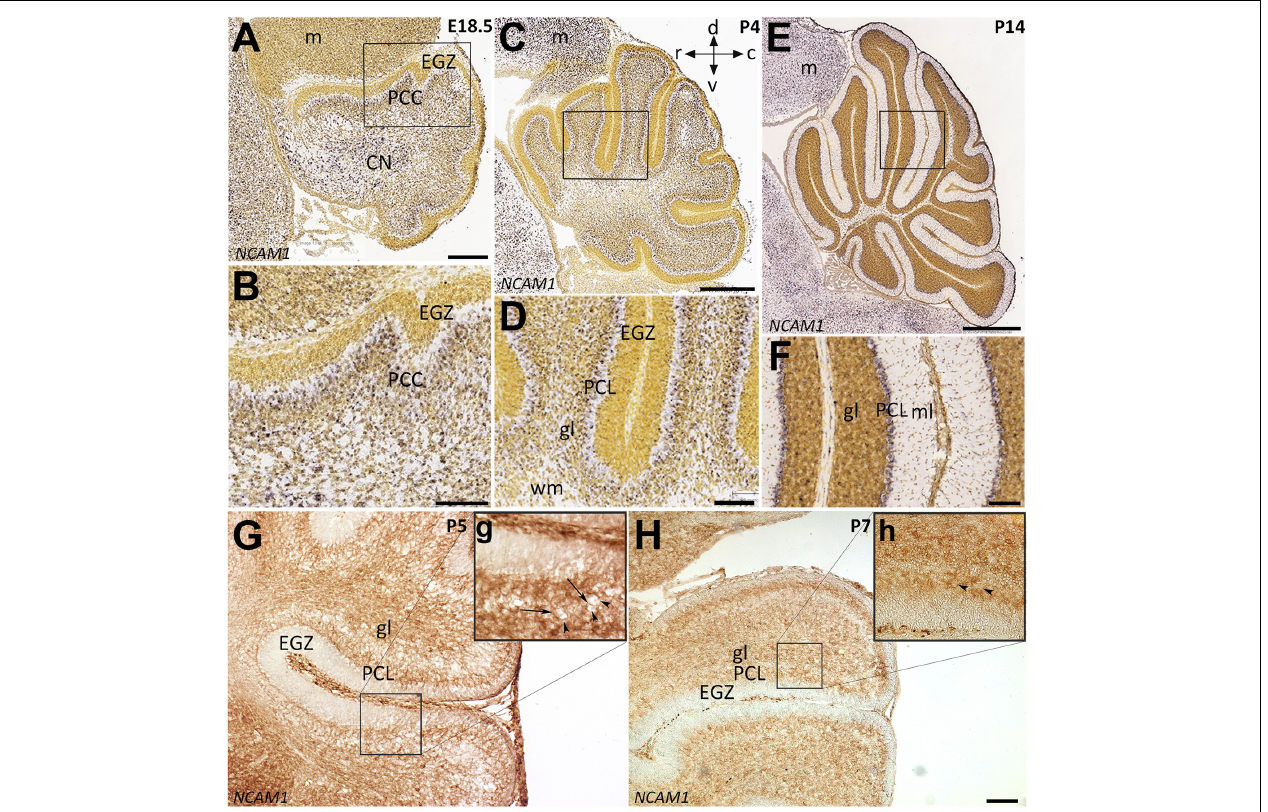
FIGURE 3 | Distribution of NCAM1 in sagittal sections hybridized in situ with antisense riboprobes specific for NCAM1 and immunoperoxidase staining in the cerebellum during development. Positive territories are labeled black. (A–D) NCAM1 expression at E18.5 and P4 is localized generally in whole cerebellum mostly in PC cluster and CN, except in EGZ and VZ (E18.5; A and P4; C , and higher magnification in B,D ). (E,F) At P14, NCAM1 expression is localized in PC layer and clearly in PC soma ( E , and higher magnification in F ). Image credit: Allen Institute. © 2008 Allen Institute for Brain Science. Allen Developing Mouse Brain Atlas. Available online at: https://developingmouse.brain-map.org/. (G,H) Sagittal sections of P5 and P7 wt mouse cerebella immunostained with NCAM1 show the expression of NCAM1 is distributed in the granular layer and in PC layer, but not in EGZ, higher magnification provided in (g,h) . CN, cerebellar nuclei; EGZ, external germinal zone; gl, granular layer; m, mesencephalon; ml, molecular layer, NTZ, nuclear transitory zone; PCL, Purkinje cell layer; PCP, Purkinje cell plate; RL, upper rhombic lip; VZ, ventricular zone; WM, white matter. Scale Bars = A = 198 µ m (applies to panels A–F ); H = 100 µ m (applies to panels G,H